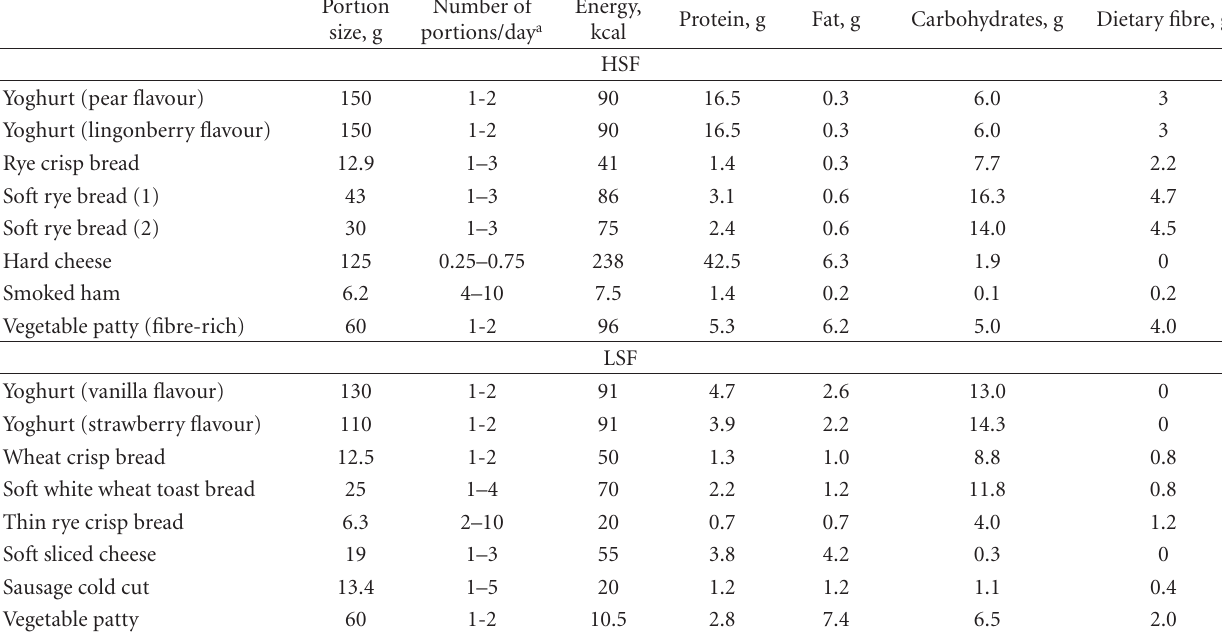
Table 5: Instructed portion sizes, possible numbers of daily portions, and their energy and macronutrient contents per portion during the